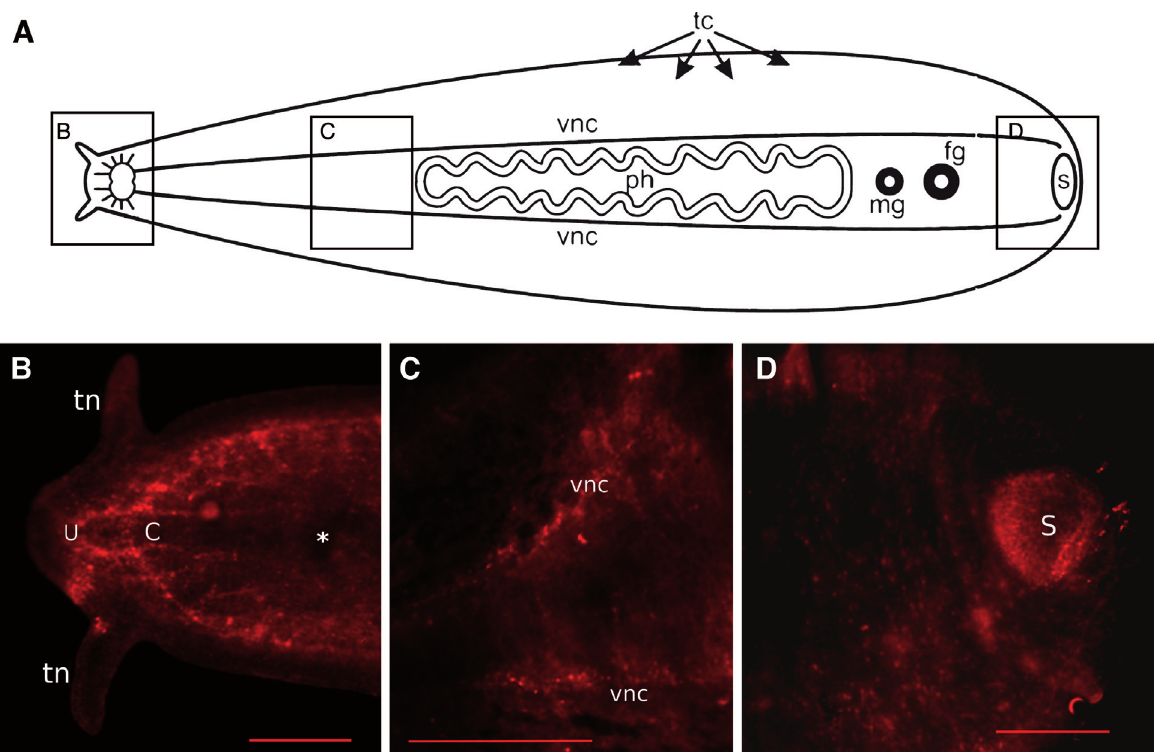
Figure 5 - Serotonin expressing neurons in Boninia divae (category III). A. Diagram of the nervous system indicates the sites shown in panels B-D. B. In the head, serotonin expression is observed in the anterior-most U-shaped nerves and anterior paired bilateral C-shaped nerve branches. Notice that no ex- pression is observed in the brain. C. Serotonin expression in the ventral nerve cords. D. Serotonergic cells in the sucker. C C-shaped structure, vnc ventral nervecords,ssucker,tntentacle,phpharynx,tctransversecommissures,UU-shapedstructure;brainlocationdenotedbyasterisk.Scalebars100 (cid:2)